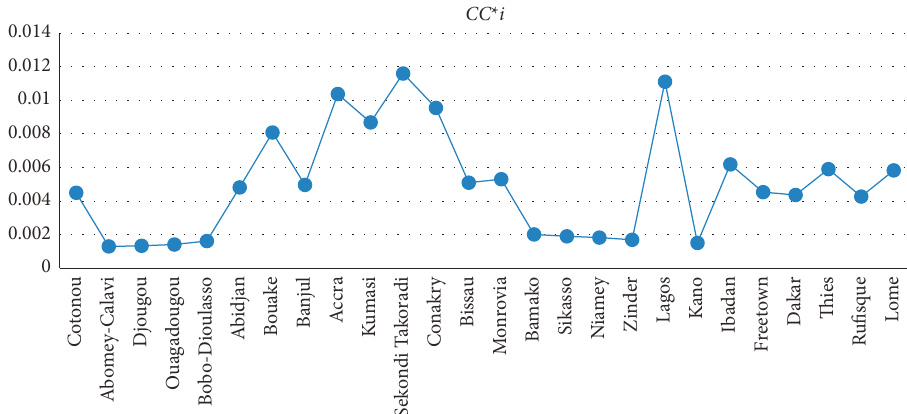
Figure 3: Node ranks of the various